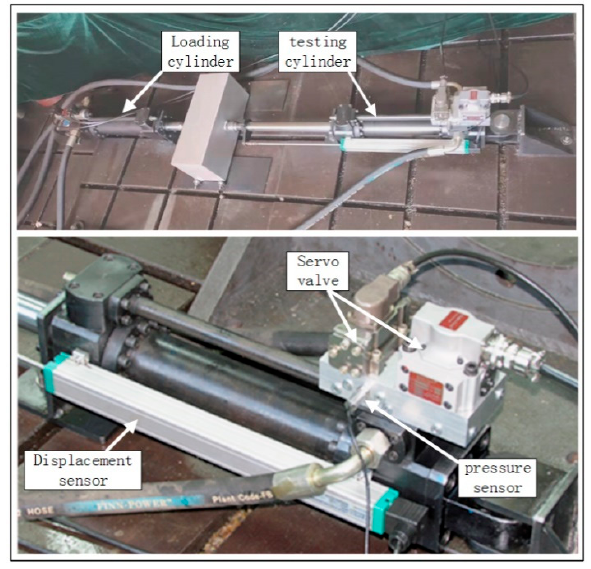
Figure 6. Photograph of the test rig used in this work.